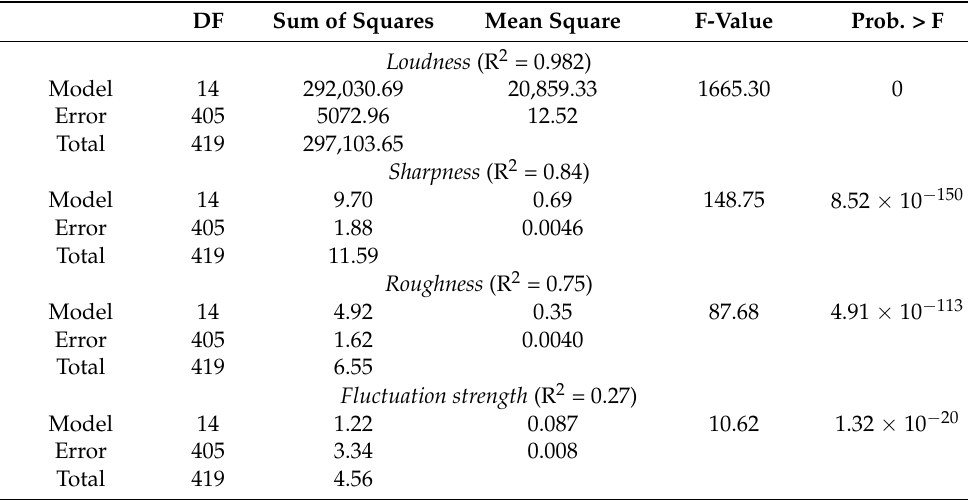
Table 4. One-way ANOVA at a confidence interval of 95%. DF Sum of Squares Mean Square F-Value Prob. > F Loudness (R 2 = 0.982) Model 14 292,030.69 20,859.33